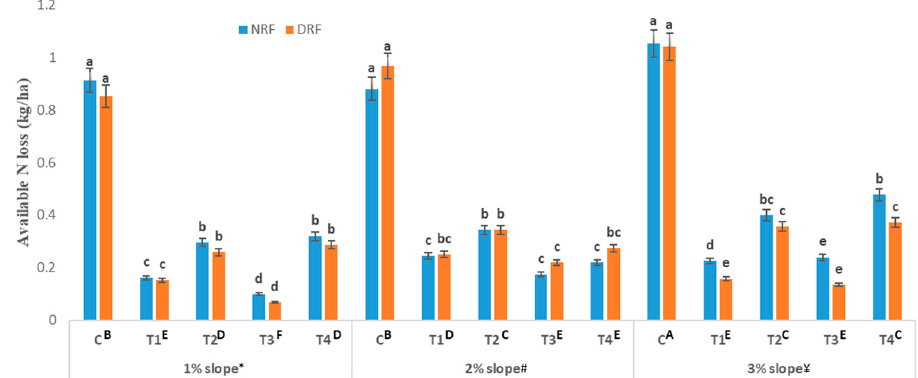
Figure 4. Available nitrogen (N) loss through runoff sediments across variable slopes (1–3%) in the normal and deficit rainfall years. ABCDEF all differ significantly at the 1% level of significance between the treatments irrespective of the slopes. abcde all differ significantly at the 5% level of significance between the treatments within a particular slope level in different rainfall situations. * #¥ all differ significantly at the 1% level of significance between the slopes. T1, the top and bottom Stylosanthes strip; T2, only the bottom strip of Stylosanthes ; T3, the top and bottom Brachiaria strip; and T4, only the bottom strip of Brachiaria .